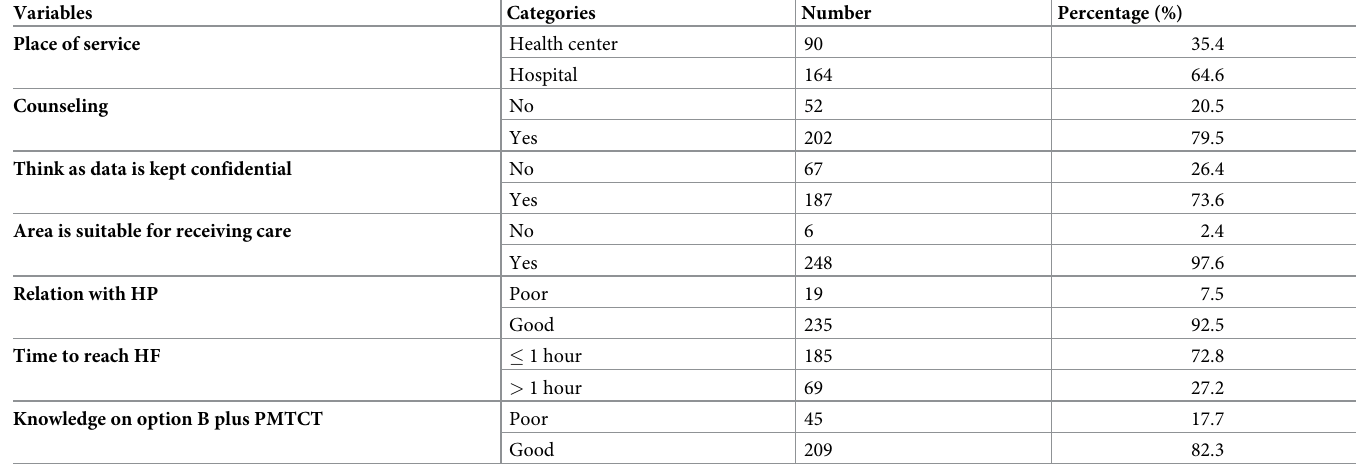
Table 2. Health service setting and health care provider relationship with the client among pregnant & lactating mothers in selected governmental health facilities of Hawassa city, Southern Ethiopia, 2019/20 G.C. Variables